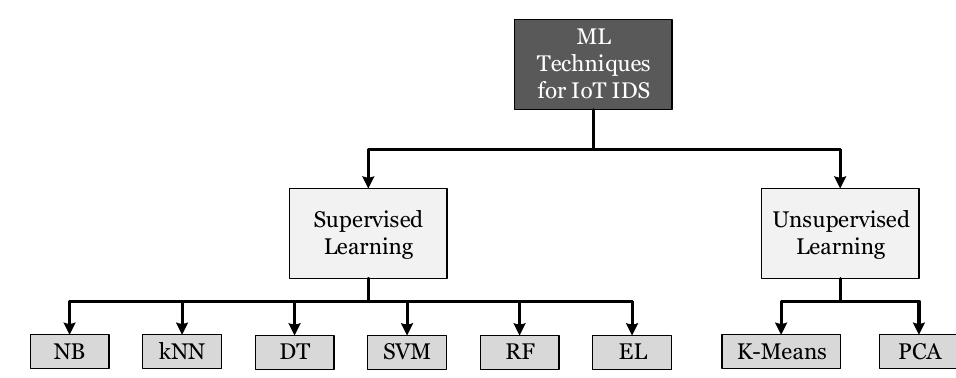
Figure 10. A taxonomy of ML Techniques for IoT-based